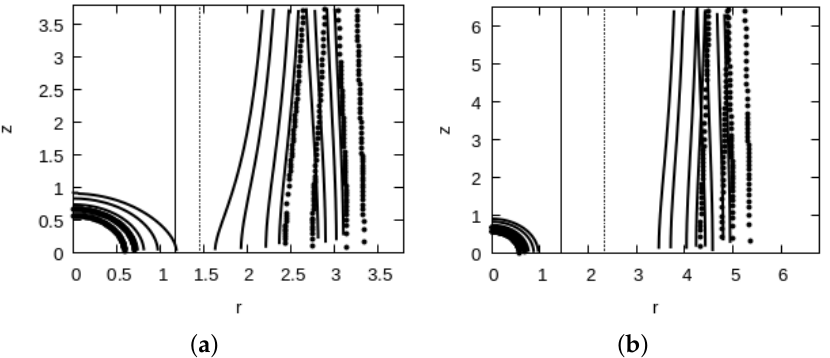
Figure 4. Potential Φ cg contour curves for a general relativistic disk (Lemos–Letelier dust disk with a central black hole). This potential is the centrifugal-gravitational potential associated with poloidal magnetic surfaces. Vertical full lines indicate the position of the BH horizon. The dotted lines indicate the ISCO position (i.e., the disk’s inner radius, where orbits are still allowed to keep their stability). In ( a ), a = 0.98 indicates that the lines of the magnetocentrifugal winds are approaching the BH horizon and could be a source of particle flow that collides with other particles close to the BH. In ( b ), the black hole spin is a = 0.9, and the magnetocentrifugal winds are too distant from the horizon to form a flow of colliding particles. Here, r in is calculated from the r ms Kerr radius in natural units, while the the curves are in terms of M units and for α = 0.1.